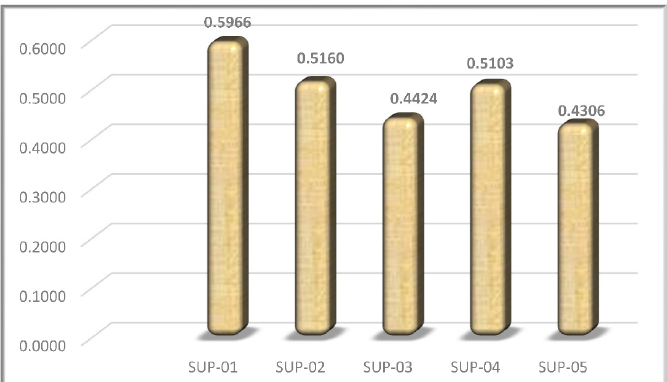
Figure 5. Ranking list of 05 potential plastics raw materials supplier. Table 6. Criteria weights in all cases.